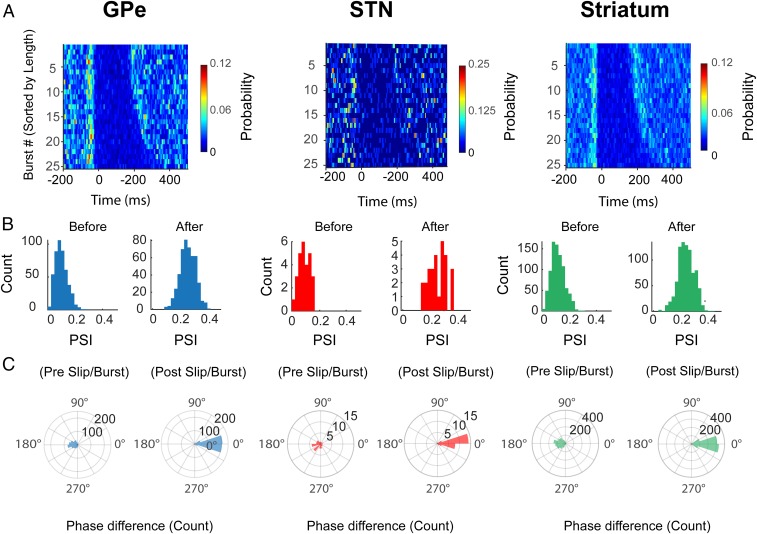
Phase slips indicate that conditions for cortical and basal ganglia phase locking have been established before the onset of ECoG β bursts. (A) Average phase slips observed during the 25 longest ECoG β bursts in each recording. The phase alignment between the ECoGβ and BUAβ altered before the cortical burst onset (time = 0), defined according to the threshold crossing. (B) Phase alignment between the ECoG and the basal ganglia BUAβ, before a phase slip, was not consistent across different epochs, highlighted by low PSI values. After phase slip, phase alignment was around twice as consistent across different trials. (C) Phase alignment immediately before a phase slip differed from the phase alignment observed during the ECoG β burst. However, immediately after a phase slip, the phase alignment between signals was the same as the phase alignment observed during the ECoG β burst (i.e., 0° difference between the phase of alignment after the slip and during the burst). (In B and C, GPe = 366, STN = 22, and Str = 209 BUA signals.)